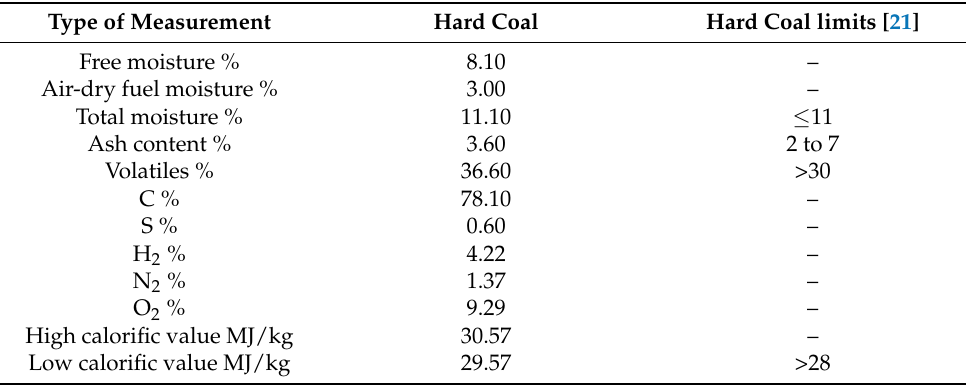
Table 3. Ultimate analysis of hard coal used during the research.